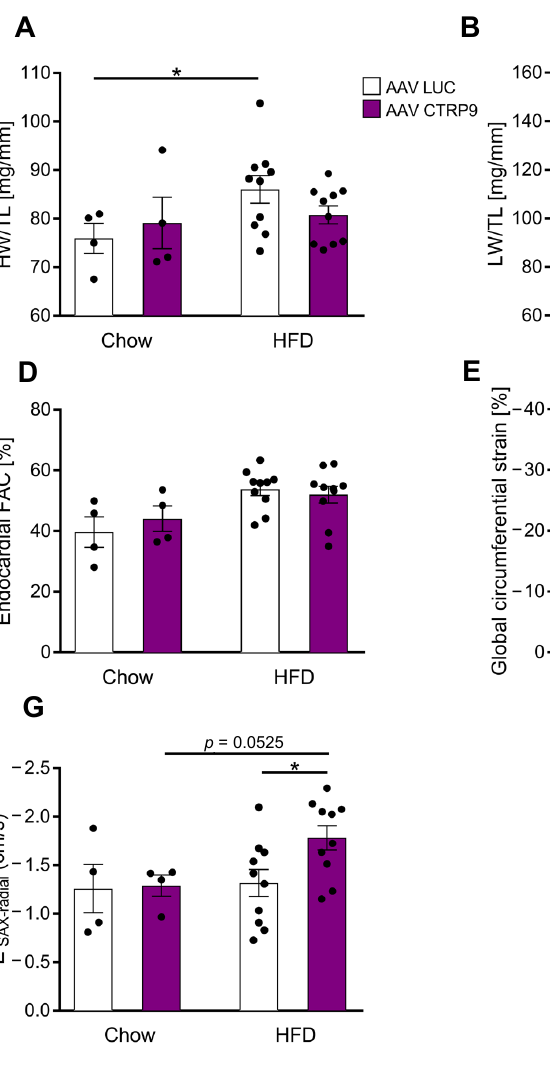
Figure 5. Overexpression of CTRP9 improves cardiac diastolic function during high-fat diet (HFD). ( A ) Ratio between heart weight (HW) and tibia length (TL) in the indicated mice treated either with AAV Luc (control) or AAV CTRP9 (leading to myocardial CTRP9 overexpression). ( B ) Ratio between lung weight (LW) and TL. ( C – G ) Echocardiographic analysis. ( C ) Enddiastolic area. ( D ) Endocardial fractional area change (FAC). ( E ) Global circumferential strain as a marker of global cardiac function. ( F ) Peak diastolic circumferential strain rate as a marker of lusitropy. ( G ) E (cid:48) SAX-radial based on average endocardial movement during cardiac relaxation. Data are shown as mean ± standard error of the mean (SEM). * p < 0.05